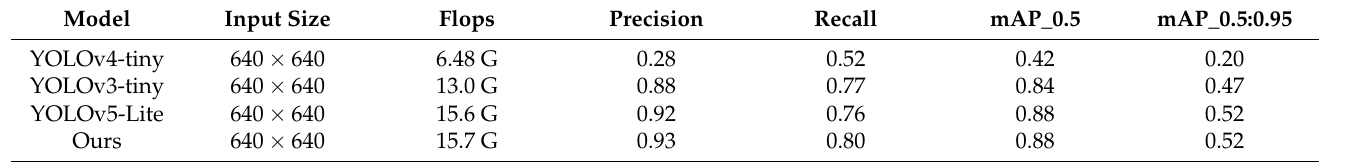
Table 4. Comparison of the detection results with other methods on the CUHK Occlusion